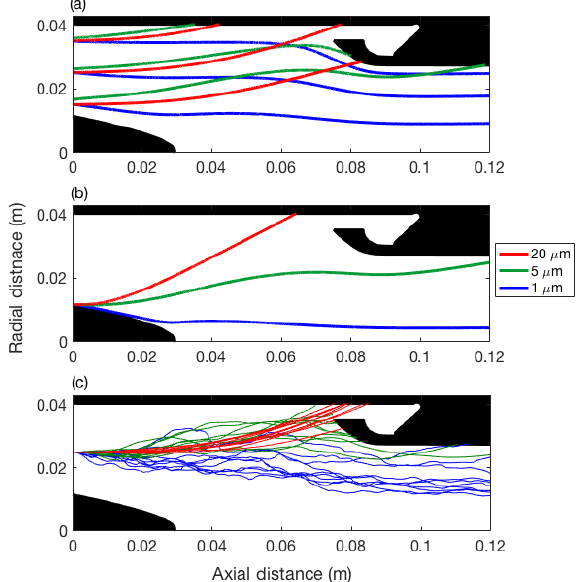
Figure 5. Capture zone droplet trajectories showing (a) variation of droplet trajectory with diameter and radial position with droplets in equilibrium with upstream flow, (b) trajectories of droplets shed at the blade trailing edge with zero initial momentum, and (c) effect of flow turbulence on an ensemble of trajectories, released as per panel (a) in the middle